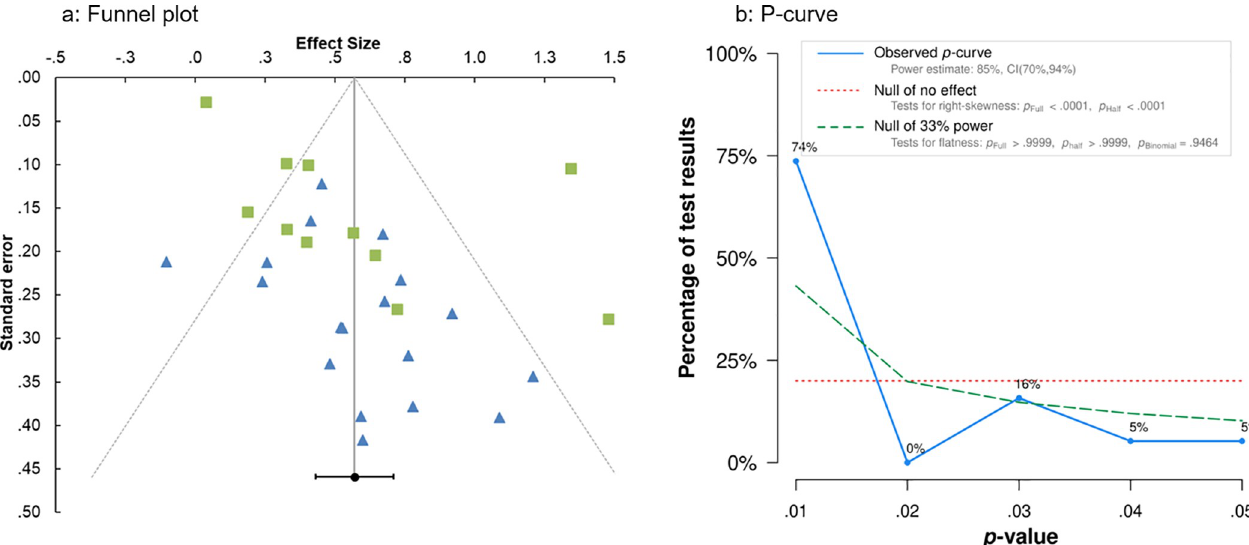
Fig 3. Presence of publication bias and p-hacking in meta-analysis. Fig 3A shows the funnel plot of individual effect sizes by strategy type. Blue triangles represent reactive strategies and green squares represent proactive strategies. The vertical red line represents the overall effect size ( d = 0.57) with the red diagonal lines representing the 95% confidence interval. Fig 3B shows the p-curve distribution of p-values from meta-analysis.